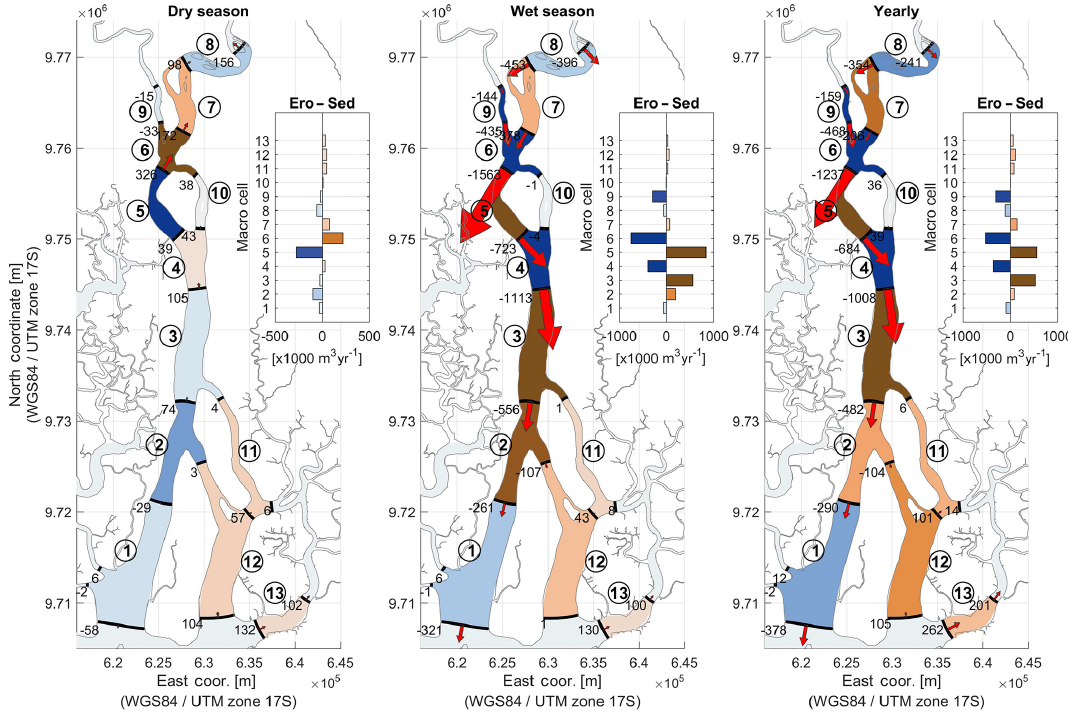
Figure 12. Sediment balance computed yearly and seasonally for El Niño (Case